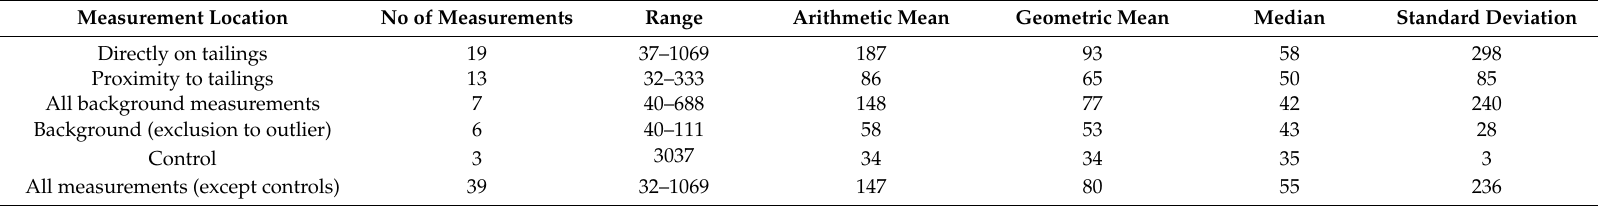
Table 2. Outdoor radon levels measured in Krugersdorp and surrounding areas, all reported in Bq / m 3